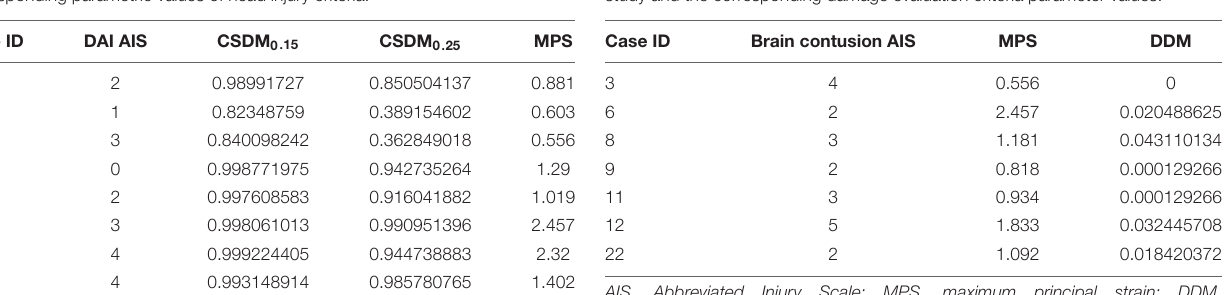
TABLE 6 | The AIS of DAI in accident cases included in this study and corresponding parametric values of head injury